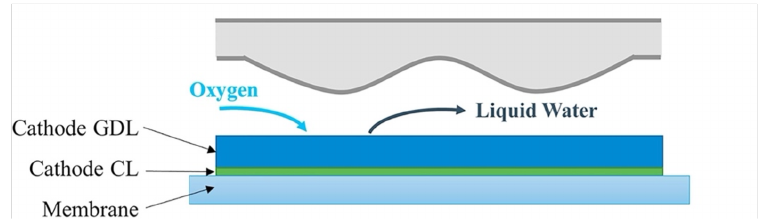
Figure 22. The novel wavy flow channel design [84].